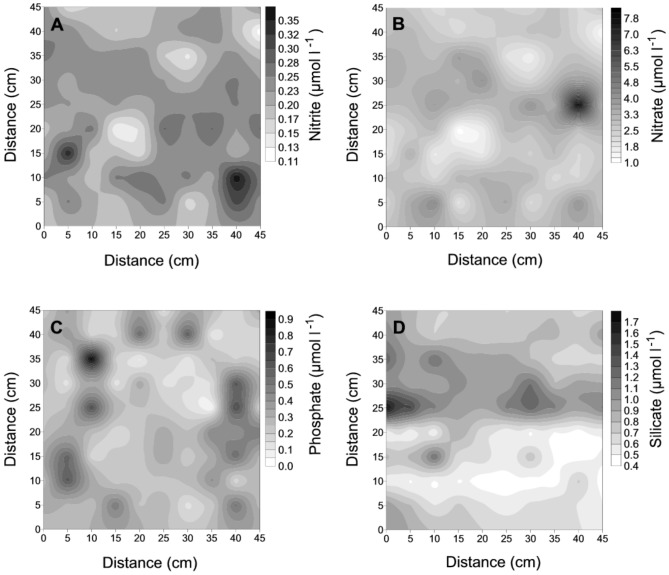
Two-dimensional (x,y) plots of nitrite (a), nitrate (b), phosphate (c) and silicate (d) concentrations estimated from an array of 10×10 syringes of 60 ml simultaneously sampled at a spatial resolution of 5 cm.The strongest changes were 3, 7, 21 and 4-fold, respectively, for nitrite, nitrate, phosphate and silicate, and were observed over distances ranging from 5 cm for silicate (d) to 20 cm for phosphate (c).